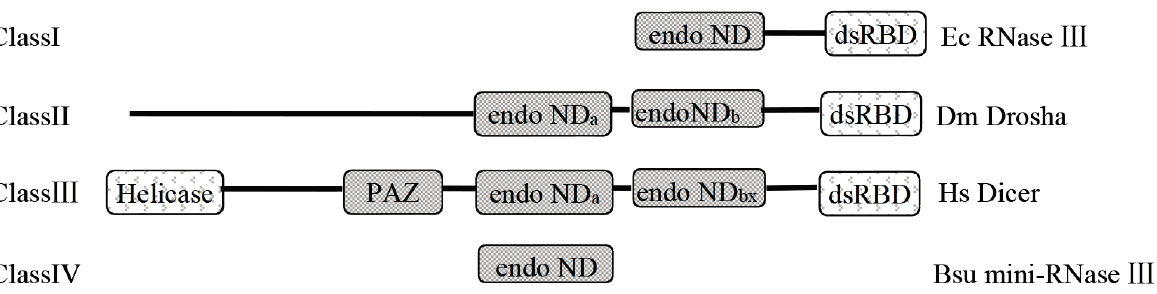
Figure 2. Schematic structures of class I–IV RNase III proteins. Ec RNase III: E. coli RNase III, SWISS-PROT PROT P05797; Dm Drosha: D. melanogaster Drosha, SWISS-PROT Q9XYN5; Hs Dicer: H. sapiens Dicer, GenBank AB028449; Bsu mini-RNase III: B. subtilis mini-RNase III (SWISS-PRO C69742). Boxes with black back ground represent catalytic endonuclease domains (endo ND) and PAZ domains (PAZ); Boxes with white back ground represent dsRNA-binding domains (dsRBD) and N-terminal DEXH-box RNA